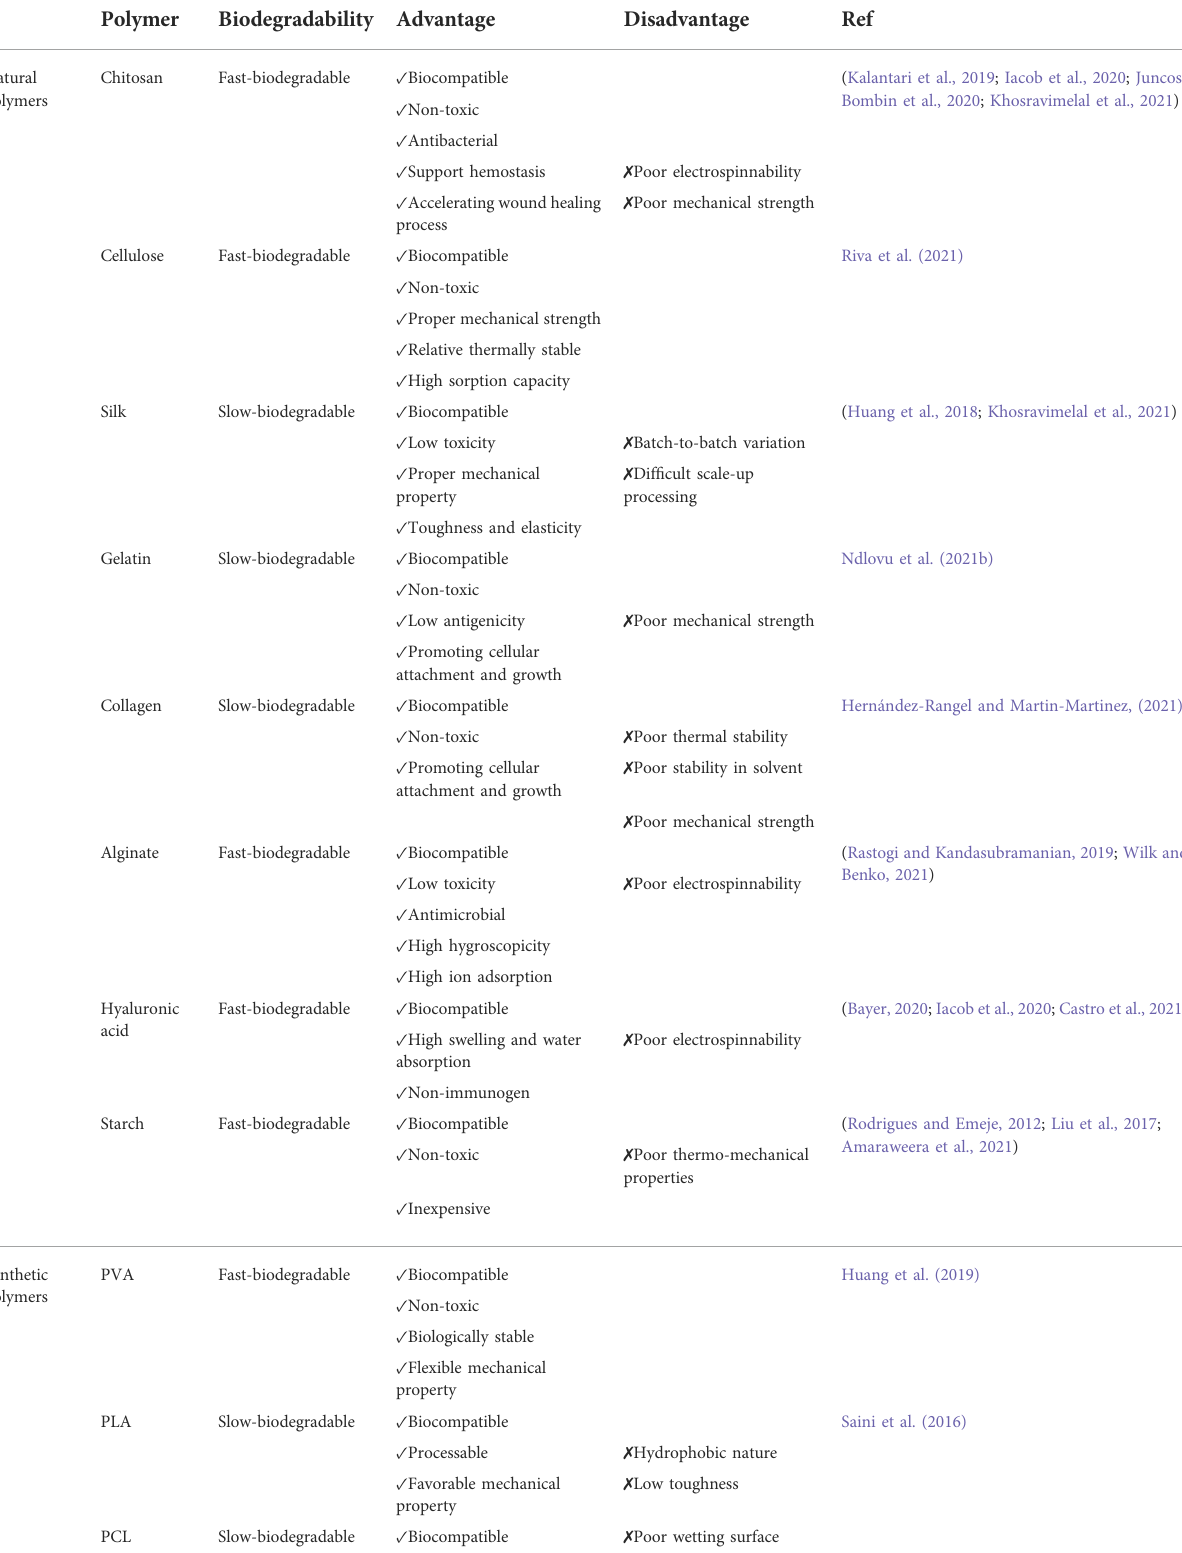
TABLE 2 Summary of natural and synthetic polymers for nano fi ber